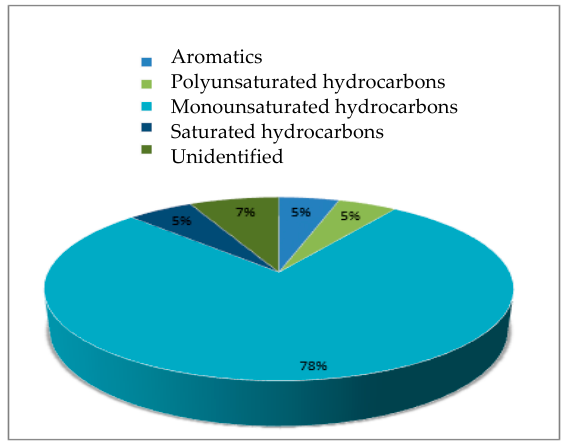
Figure 8. The yield of fast pyrolysis products of lauric acid at 650 °C in the presence of Al-MCM-41.